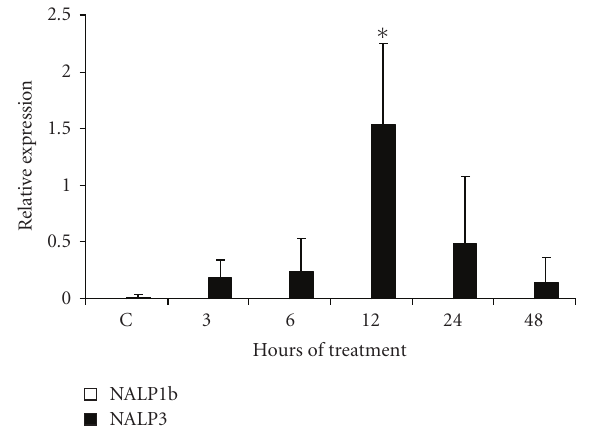
Figure 4: Expression analysis of NALP3-inflammasome components in the eye of LPS-treated mice . Semiquantitative RT-PCRs were performed for the analysis of NALP3, ASC, caspase-1, IL-1 β , and IL-18 expression in the eye of LPS-treated mice. Average of 5 mice analyzed in each assayed time is reported. Asterisk indicates significant di ff erence compared with the control ( P < . 05) analyzed by Kruskal-Wallis and Turkey